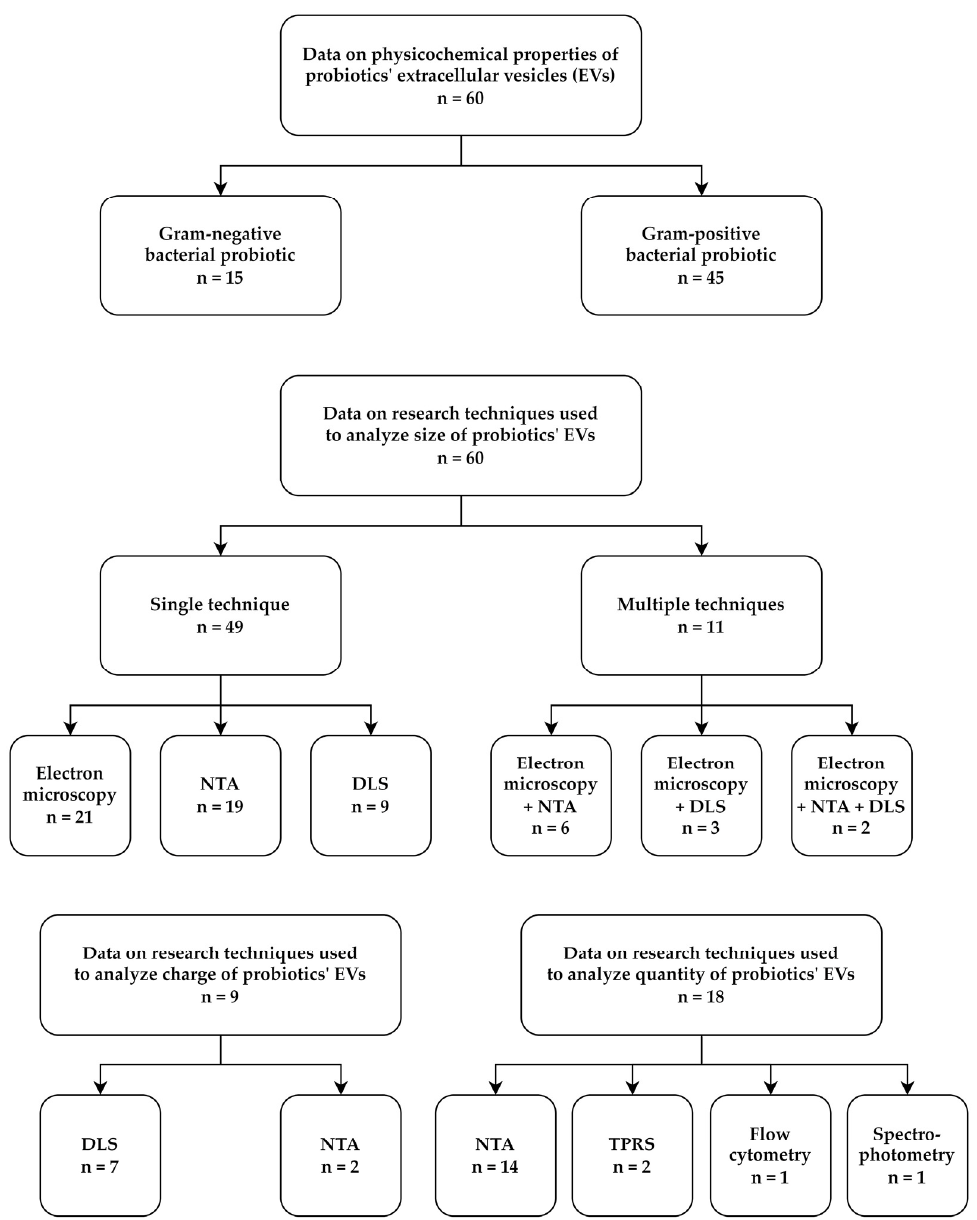
Figure 1. A graph presenting the categorization of articles constituting the core of this review, in which the physicochemical properties of extracellular vesicles (EVs) of probiotics were described. Among the 60 of them, 15 and 45 concerned Gram-negative and Gram-positive bacteria, respectively. All articles assessed the size of the produced EVs, of which 49 determined it using only one technique (21 with electron microscopy [51–71], 19 with NTA [72–90], and 9 with DLS [42,45,49,50,91–95]), while 11 used more than one technique (6 with electron microscopy + NTA [29–34], 3 with electron microscopy + DLS [35–37], and 3 with electron microscopy + NTA + DLS [38,39]). Only 9 papers analyzed the electrical charge of EVs, of which 7 used DLS [31,36–39,42,45] and 2 used NTA [84,85]. The quantity of EVs produced was examined in 18 articles, of which 14 used NTA [31,33,38,39,72–74,76,77,79,83,87–89], 2 used TRSP [49,50], 1 used flow cytometry [45], and 1 used spectrophotometry [51]. Detailed information on the numerical data of the above-presented results can be found in Table S1. Abbreviations: DLS, dynamic light scattering; NTA, nanoparticle tracking analysis; TRSP, tunable resistive pulse sensing.